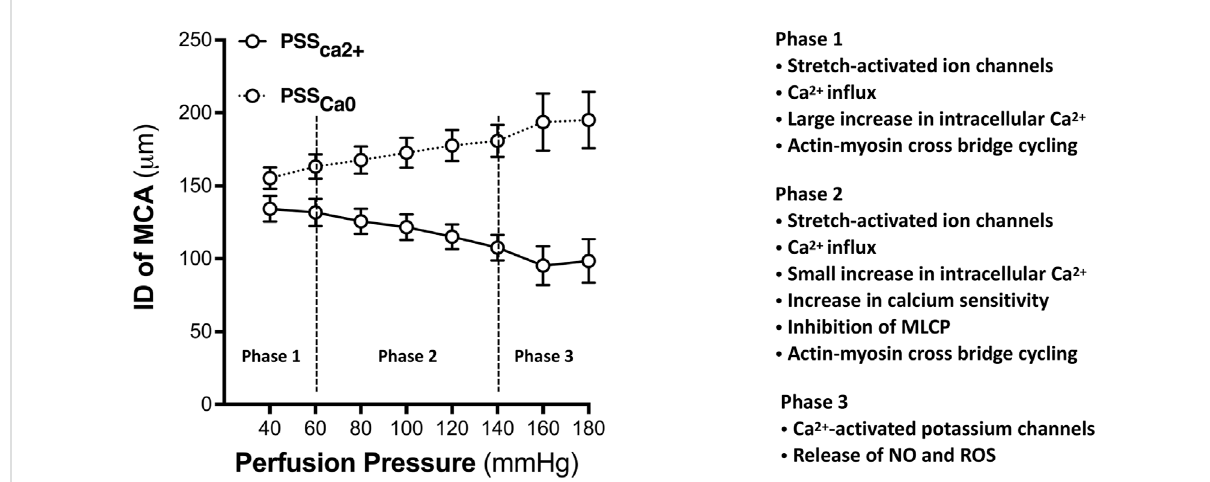
FIGURE 1 A three-phase model of myogenic behavior of the MCA. Phase 1: the myogenic tone develops at the pressures approximately 40 mmHg in the MCAfreshlyisolatedfrom3-month-oldhealthymaleSDrats.Duringthisphase,theMCAconstrictsrelativetoitspassivedistensionstate.Generation of the myogenic tone is initiated by pressure-induced activation of mechanosensors, which transduces into subsequent biological signaling events resulting in a large increase in intracellular calcium concentrations that promote actin-myosin cross-bridge mediated vasoconstriction. Phase 2:Themyogenicresponse isgeneratedatpressurefrom60to 140 mmHg.Inthisphase,onlyasmallchangeinthediameter oftheMCAwithaslight increase of intracellular Ca2+ despite a signi fi cant increase in contractile force. Calcium sensitivity plays a vital role in this phase. Phase 3: Forced dilatation occurs when pressure exceeds 140 mmHg. This phase displays active vasodilation associated with the activation of Ca2+-activated potassium channels. PSSCa2+ represents the active curve of myogenic response when vessels in PSS solution with Ca2+. PSSCa0 represents the passive curve when vessels in PSS solution without Ca2+. Data are presented as mean values ± SEM. The MCAs were obtained from 5 SD rats. PSS, Physiological salt solution; ID, Inner diameter; MCA, Middle cerebral artery; GPCRs, G-protein-coupled receptors; MLC20, 20 kDa Myosin light chain; CaM,